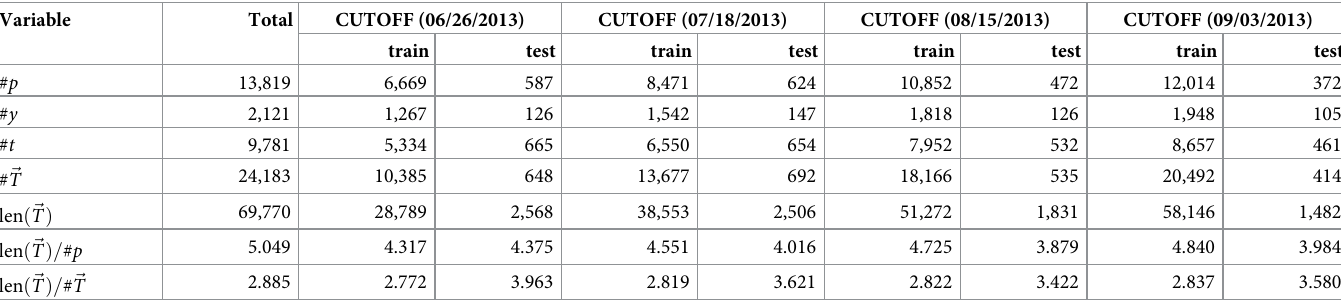
Table 3. INPC data set used in study: Total and by cutoff